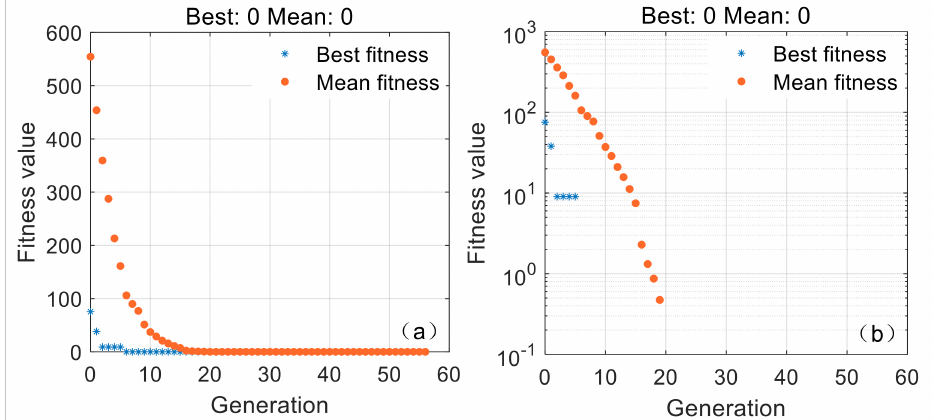
Figure 5. The fitness function value during the inversion search with an ordinate on ( a ) a normal scale and ( b ) a logarithmic